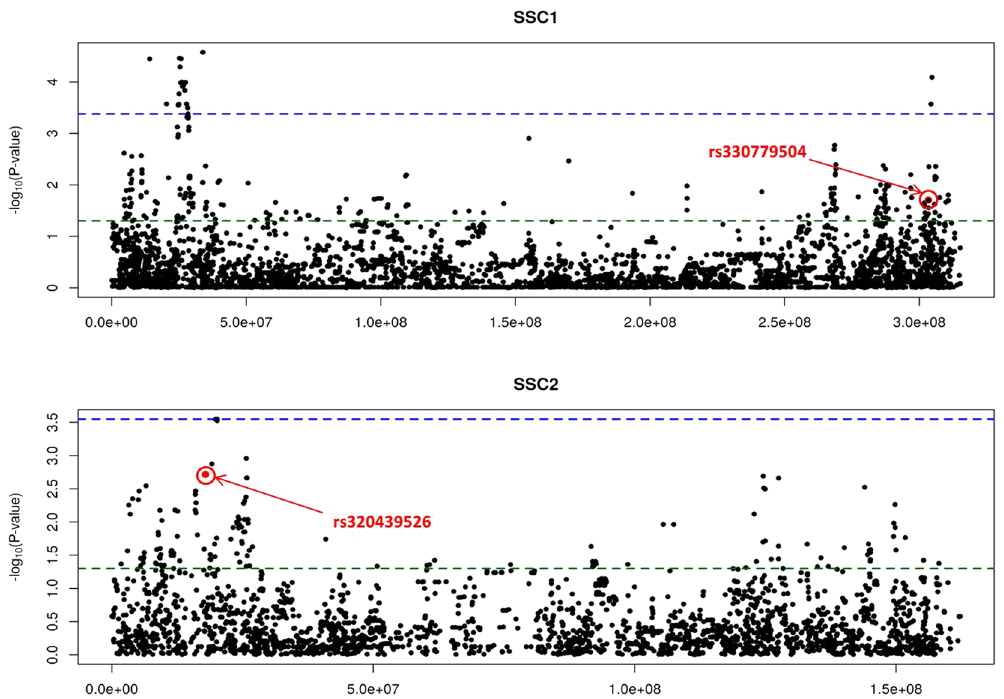
Figure 2. ( A ) Manhattan plot depicting the association of SNP rs330779504 and 7,188 additional SNPs mapping to pig chromosome 1 (SSC1) with serum low density lipoprotein concentration at ~190 days of age recorded in 345 Duroc pigs (Lipgen population). ( B ) Manhattan plot depicting the association of SNP rs320439526 and 3,684 additional SNPs mapping to pig chromosome 2 (SSC2) with stearic acid content in the longissimus dorsi muscle. The green line represents the nominal P-value of significance, while the blue line indicates the P-value of significance after correcting for multiple testing with an FDR